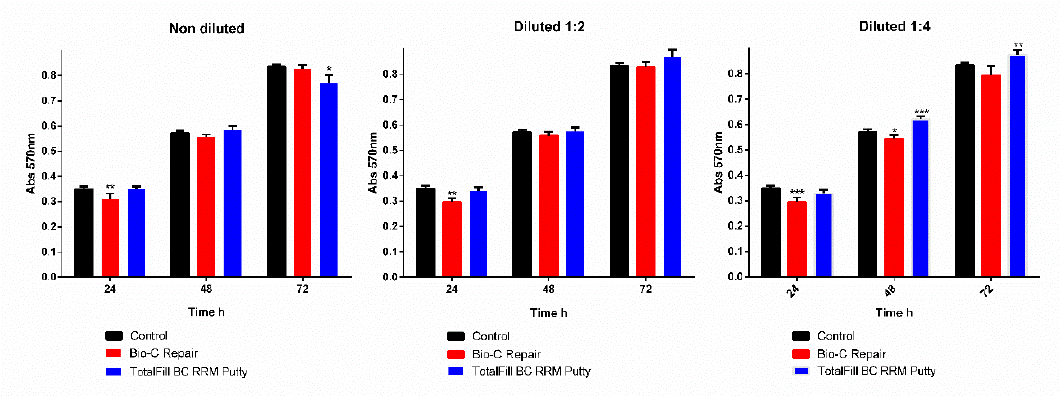
Figure 2. Cytotoxicity assay. Evaluation of human periodontal ligament stem cells (hPDLSCs) treated with Bio-C Repair and TotalFill BC RRM putty eluates. Data shown are the mean ( ± SD) of three different experiments. Cytotoxic differences observed are shown as * p < 0.05, ** p < 0.01, and *** p < 0.001, respectively.